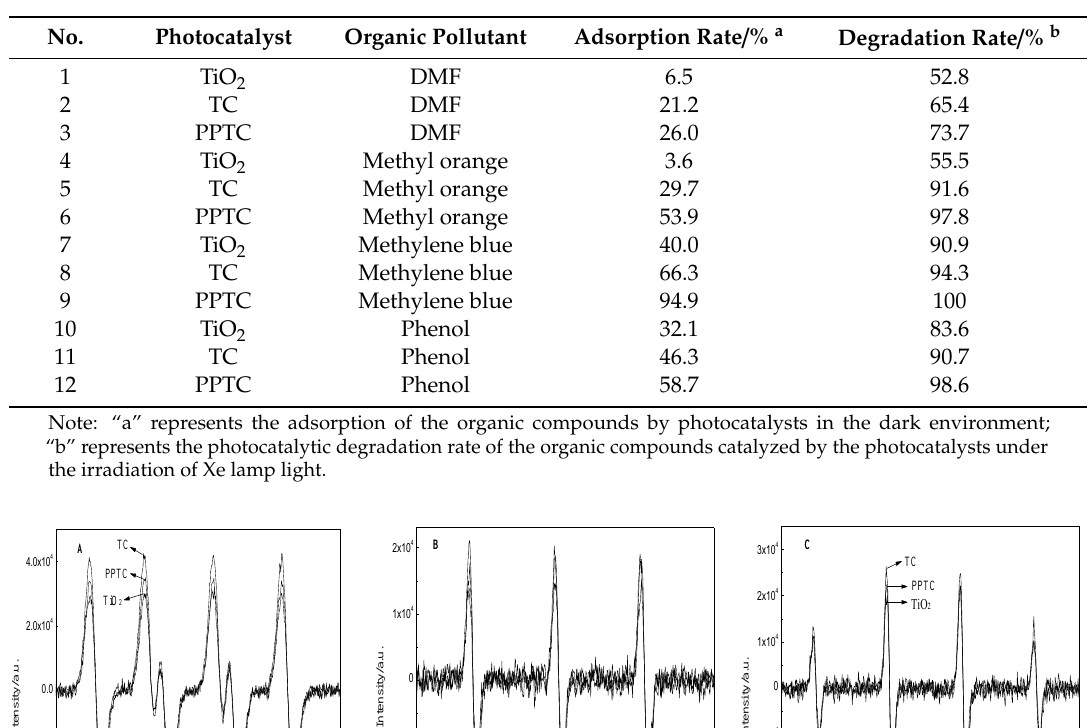
Table 3. Photocatalytic degradation rates of several organic pollutants catalyzed by TiO 2 , TC, and PPTC in the dark and under the irradiation of Xe lamp light.